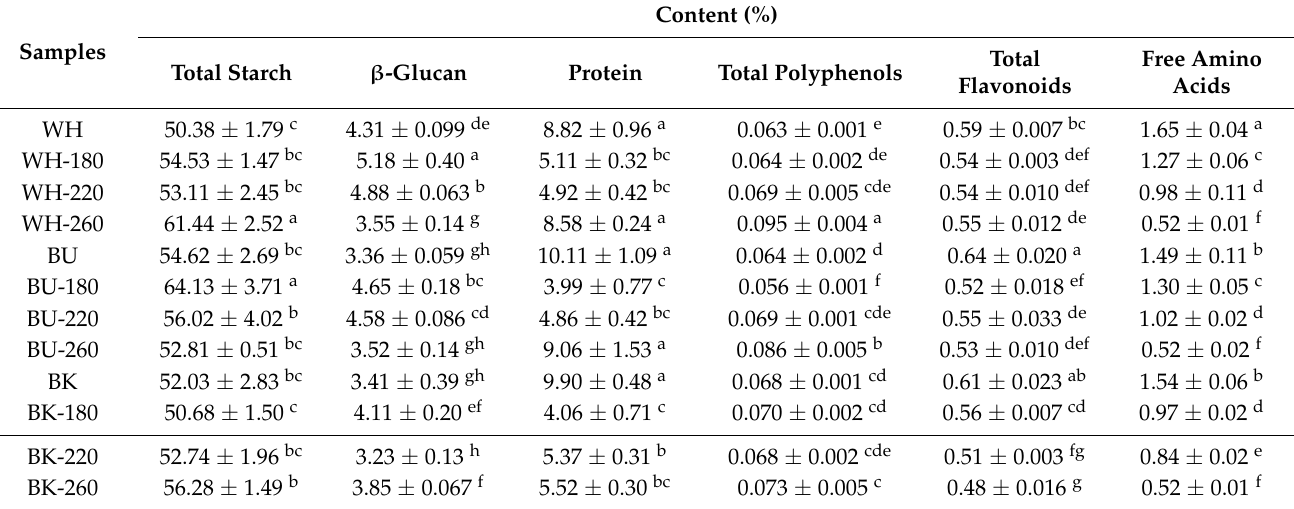
Table 3. Chemical composition of CHB roasted at different